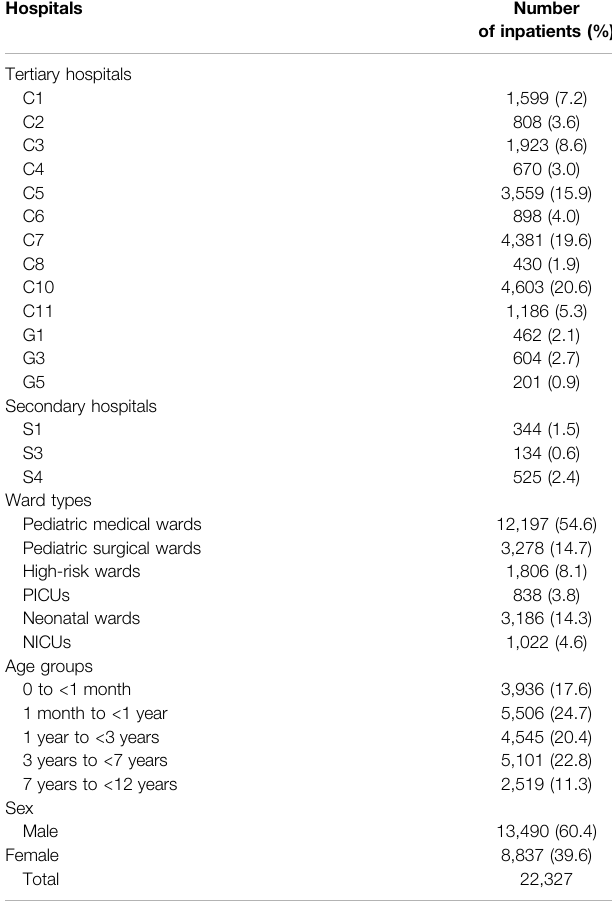
TABLE 1 | General information of sampled hospitalized